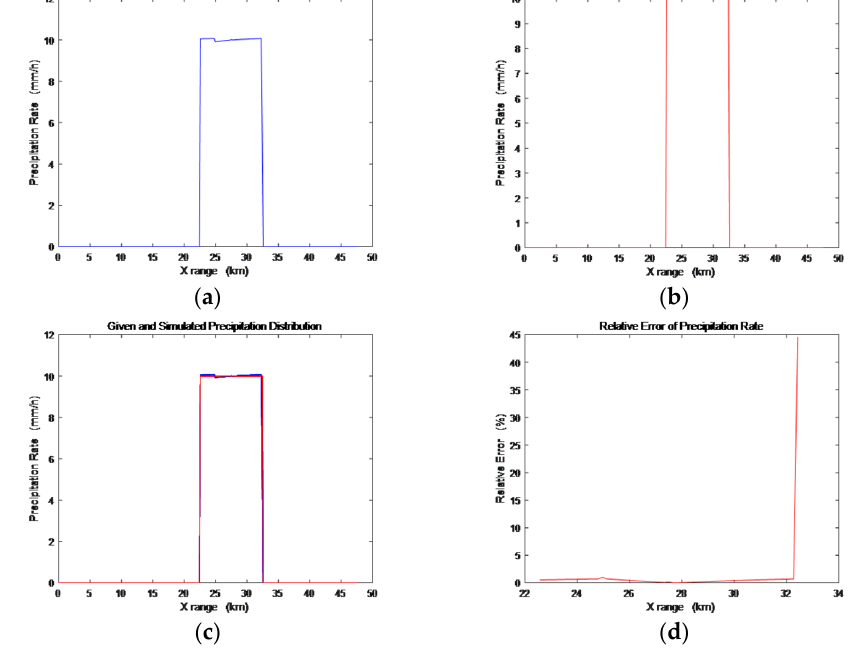
Figure 2. Rectangular distribution diagrams for 𝑅(𝑥) = 10 mm/h . ( a ) Given precipitation distribution; ( b ) Simulated precipitation distribution; ( c ) Given precipitation distribution and simulated precipitation distribution; ( d ) Relative error between given and simulated result.